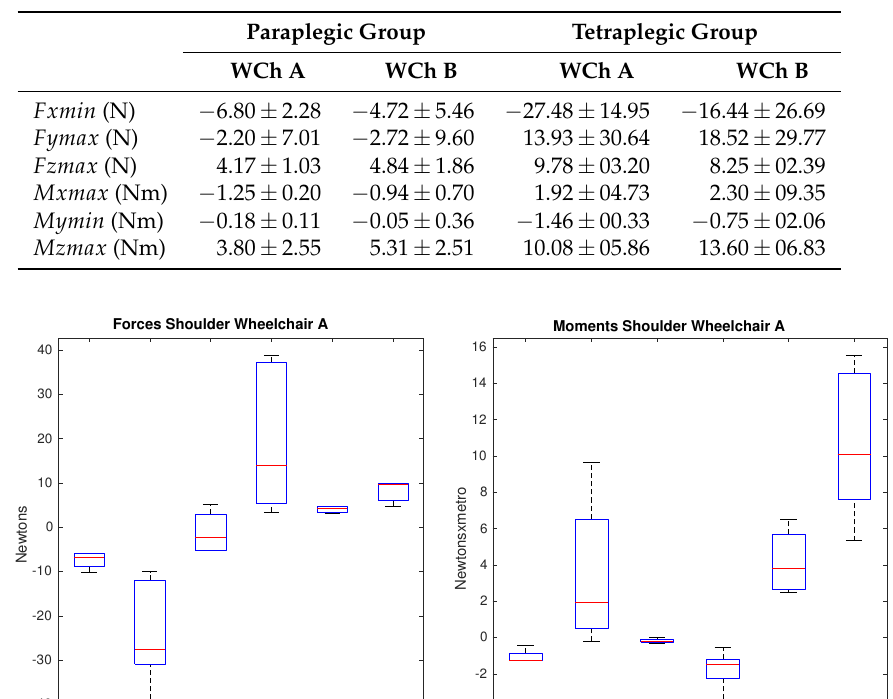
Table 8. Forces and moments that show significance on the shoulder (median ± IQR).